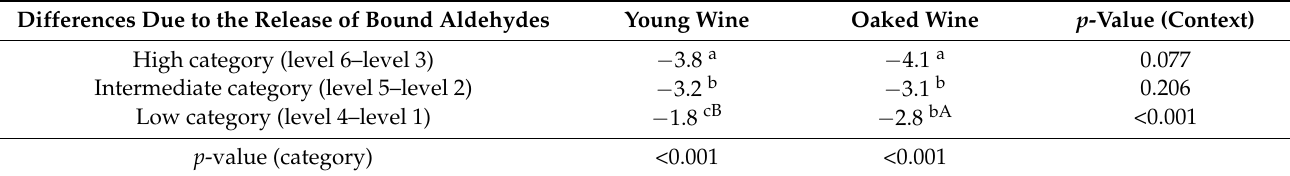
Table 4. Aroma quality differences due to the release of bound